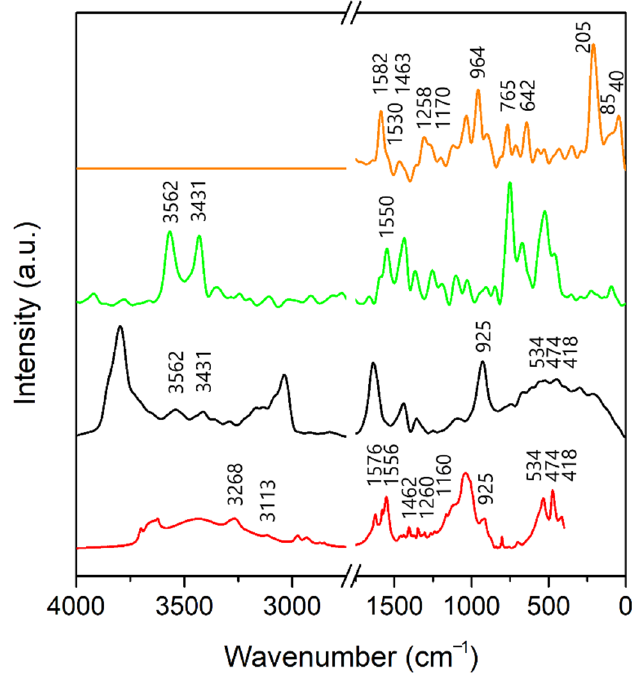
Figure 7. The experimental (red) and calculated VDOS (black), the projected VDOS of the NH groups (green) and the projected VDOS of the triazine ring (orange) for the A-Bd model.